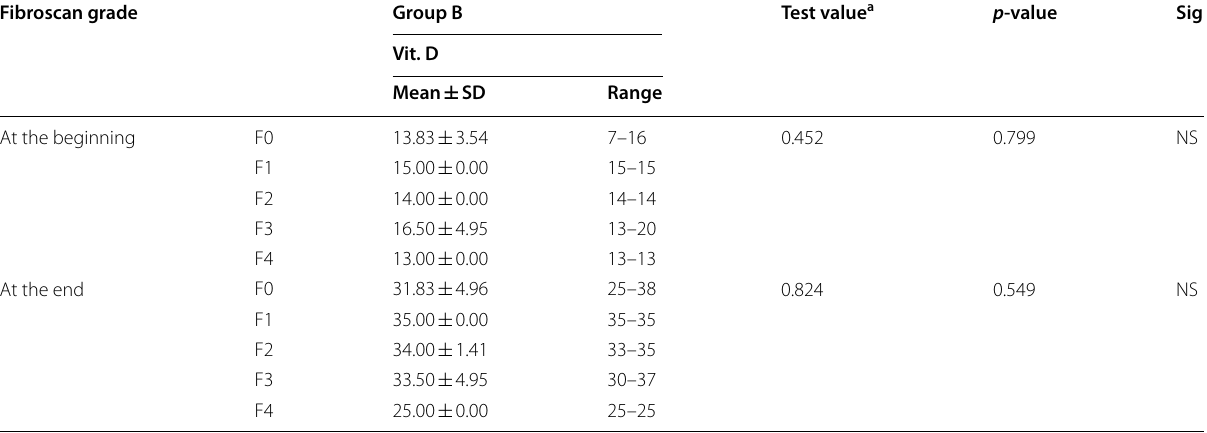
Table 11 Relation between vitamin D with fibroscan grade at the beginning and at the end in group